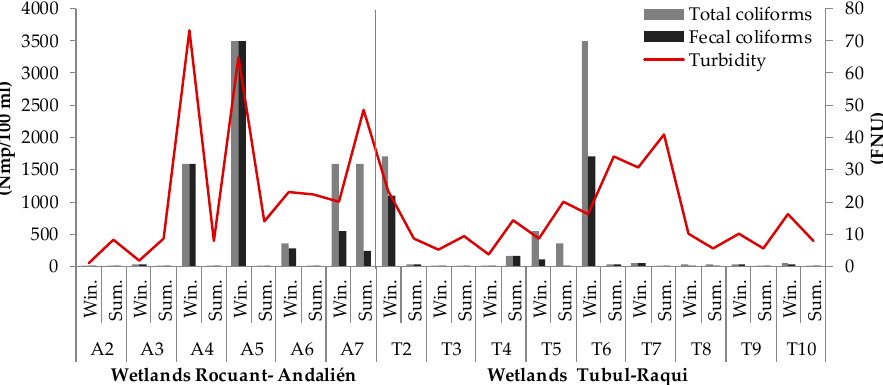
Figure 6. Diagram of coliform content and turbidity in both wetlands.